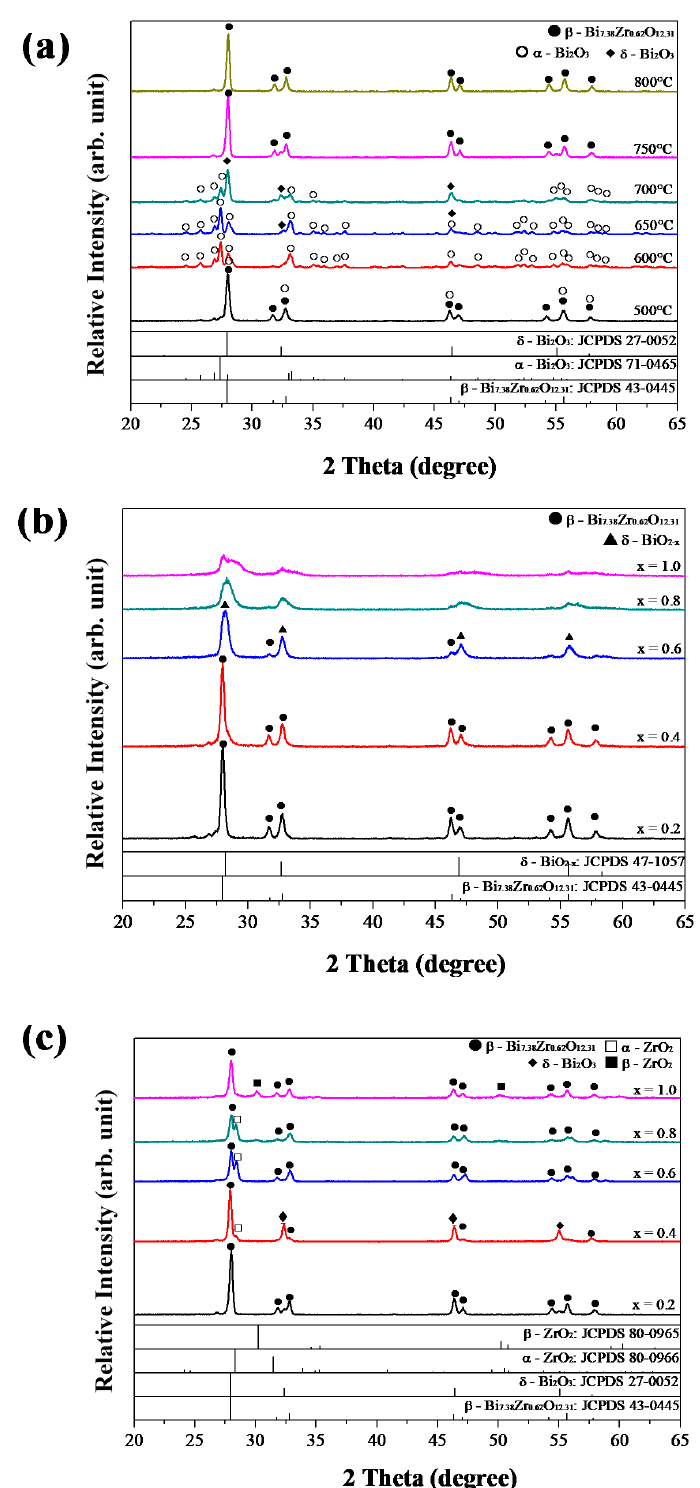
Figure 6. XRD patterns of ( a ) Bi 1.8 Zr 0.2 O 3.1 after heat treatment at different temperatures and Bi 2 − x Zr x O 3+x/2 (x = 0.2 to 1.0, 0.2 each) after heat treated at ( b ) 500 and ( c ) 750 °C.